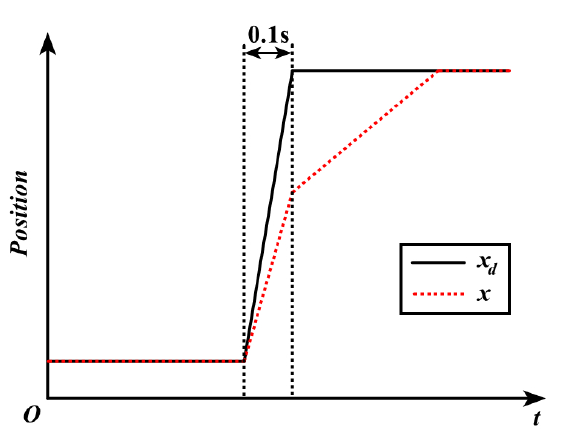
Figure 4. The hydraulic cylinder is expected to extend a certain distance in only 0.1